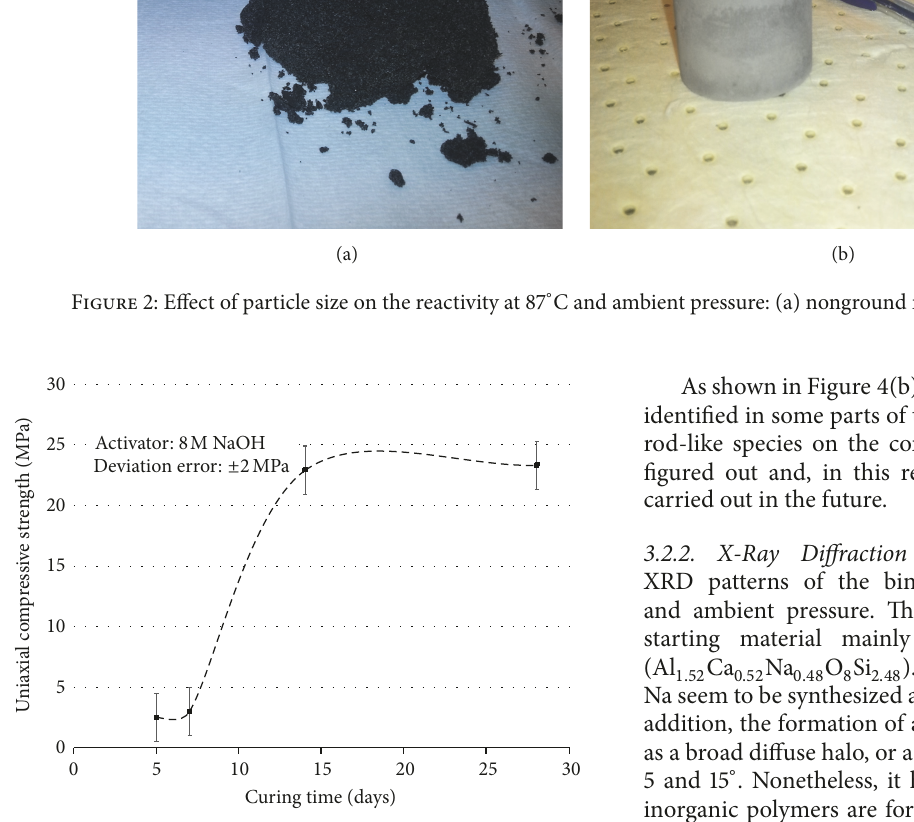
Figure 3: Strength development of specimen 1 at 87 ∘ C and ambient